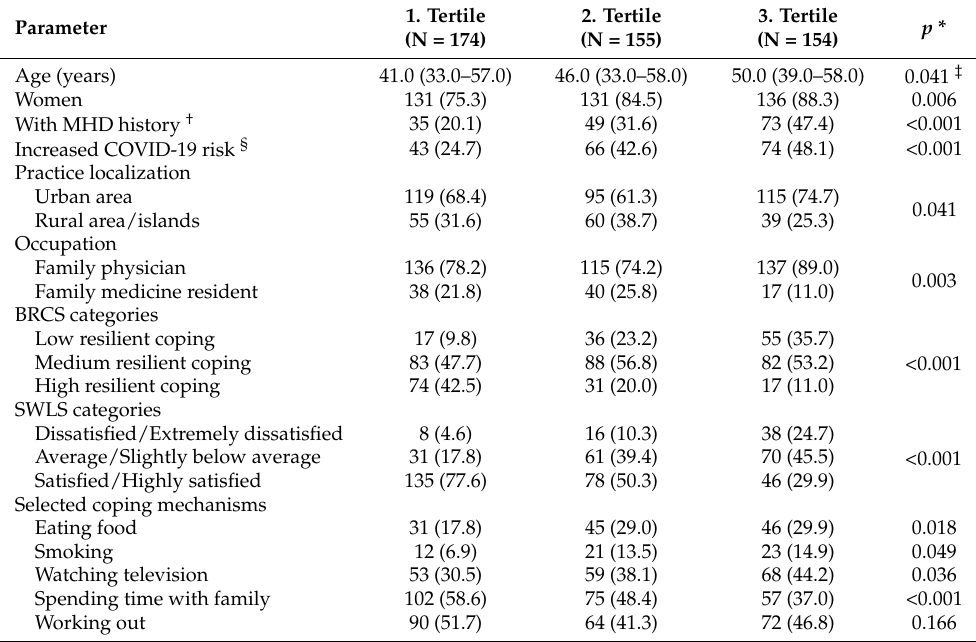
Table 5. OBI total score tertiles according to various relevant parameters in study population.